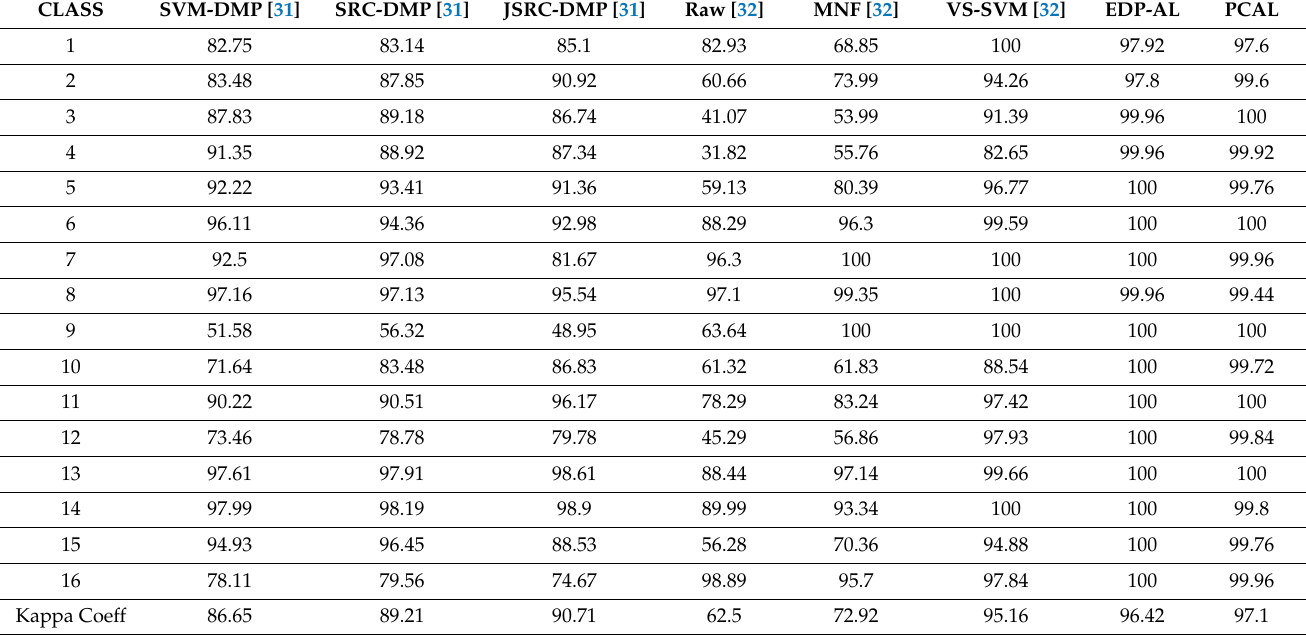
Table 4. Accuracy and Kappa Coefficient Analysis (Indian Pines).